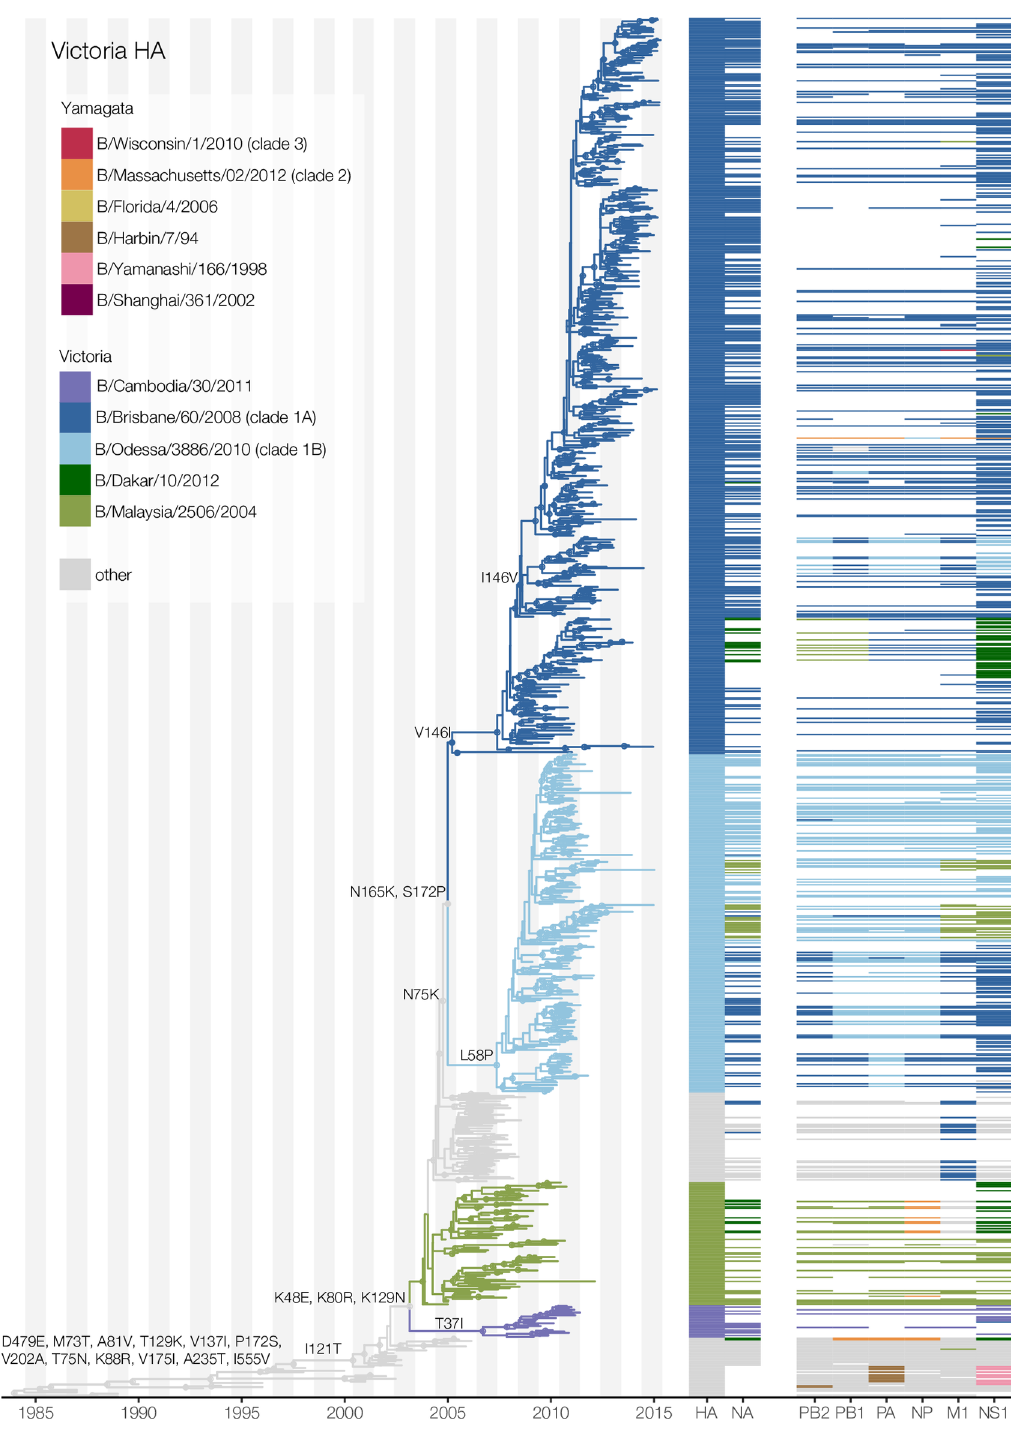
Fig 3. Maximum clade credibility tree inferred from 1,019 Victoria-lineage HA gene sequences and corresponding genotype constellations. See legend to Fig 2 for details.